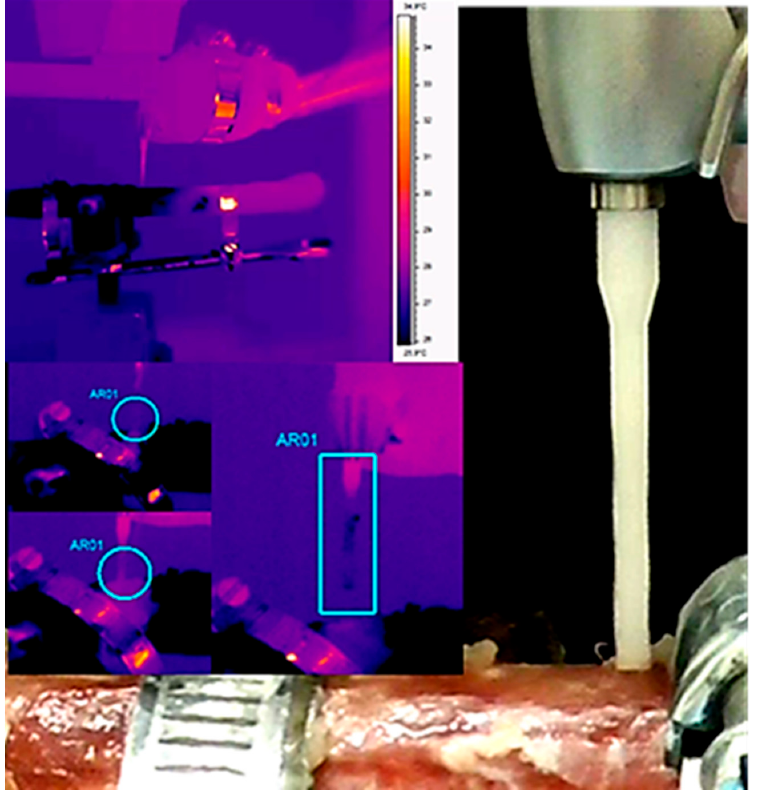
Figure 4. Infrared thermography temperature evaluation of the zirconia cylindrical drill (2 mm).